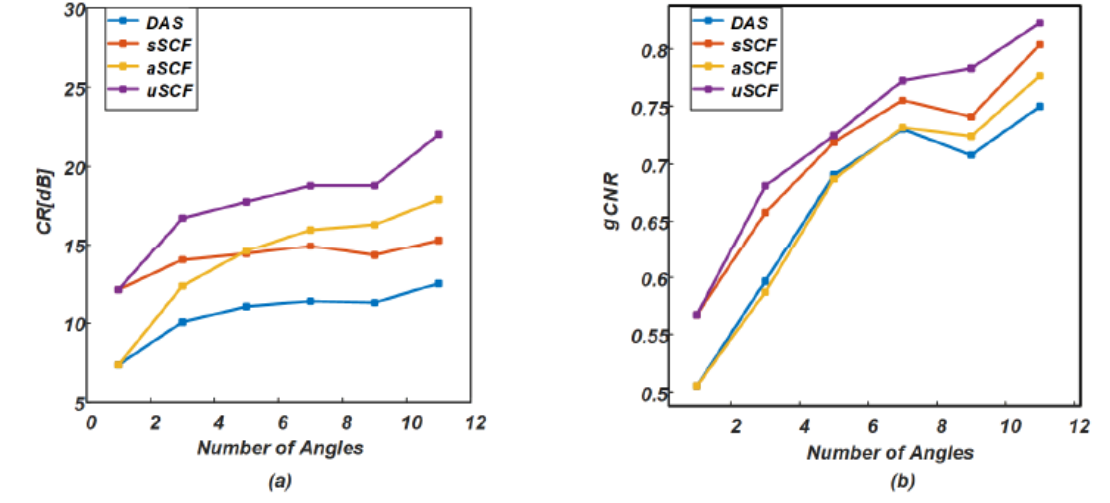
Figure 8. ( a ) CR and ( b ) gCNR as a function of the number of angles.